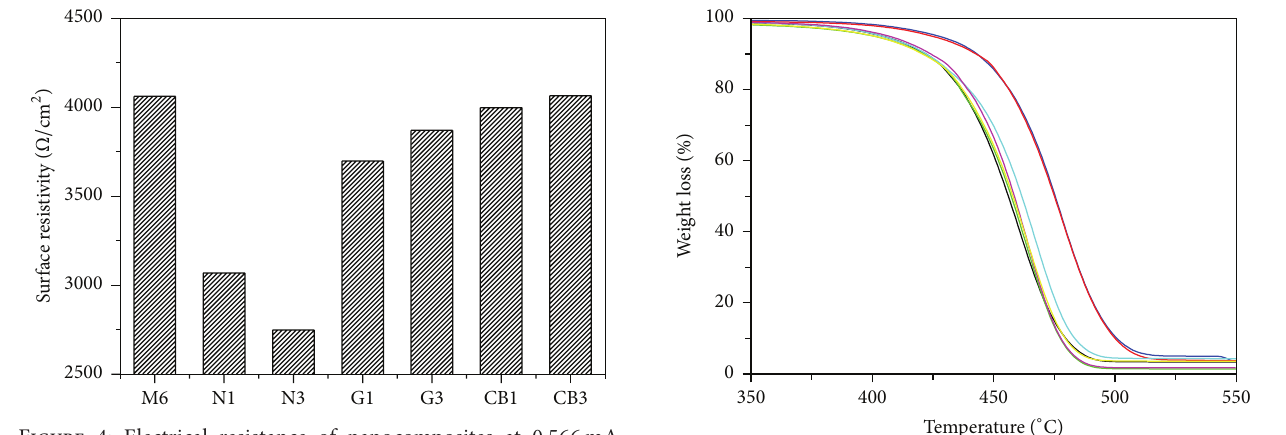
Figure 4: Electrical resistance of nanocomposites at 0.566 mA current intensity.